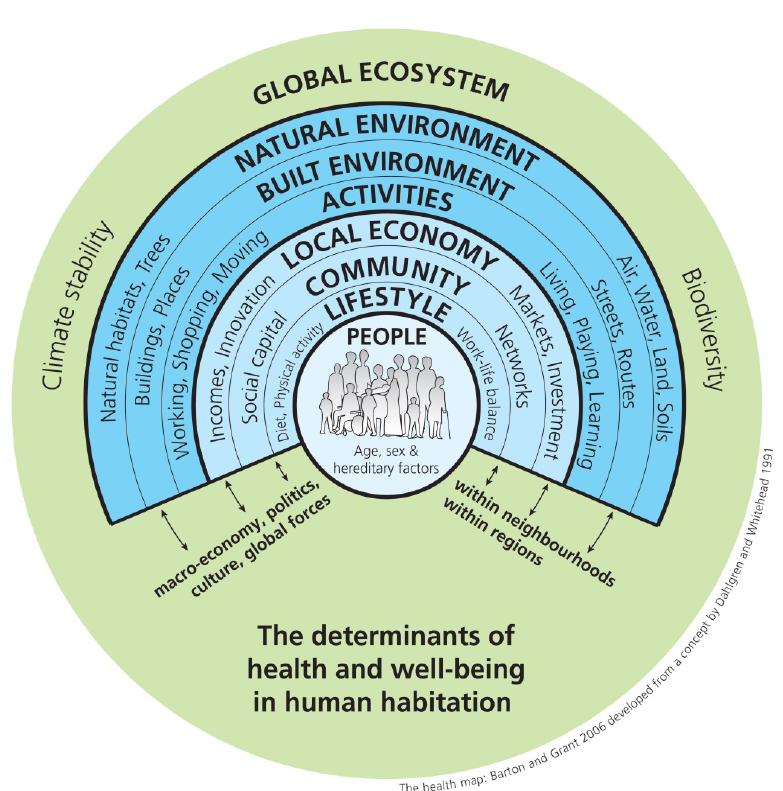
Figure 4. The Health Map